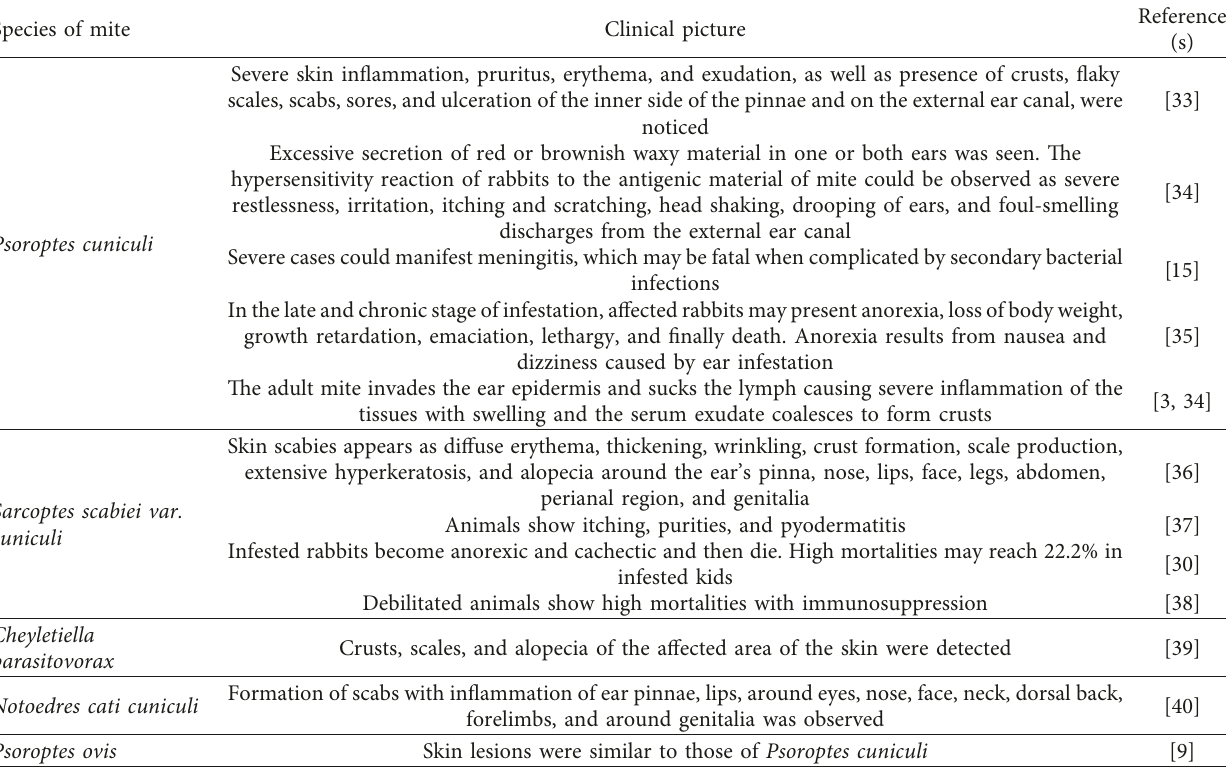
Table 1: Clinical pictures of different mite species infest